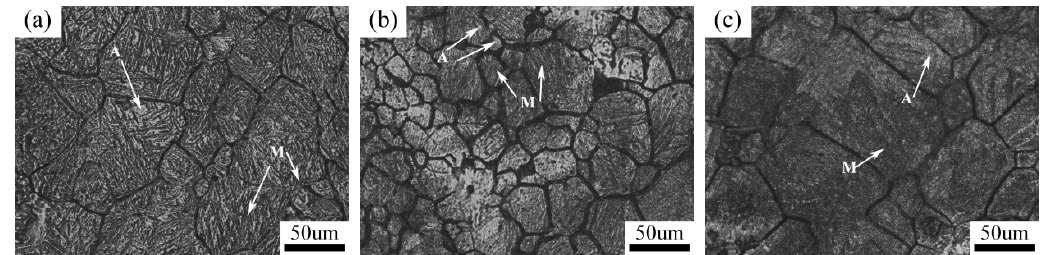
Figure 12. Microstructure of the complete quenching zone at different heat inputs. ( a ) 4.2 kJ/cm, and